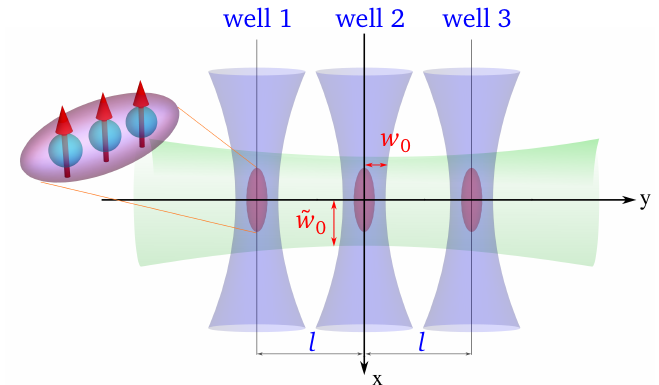
. The three beams are 0 . The wells are separated by a 0